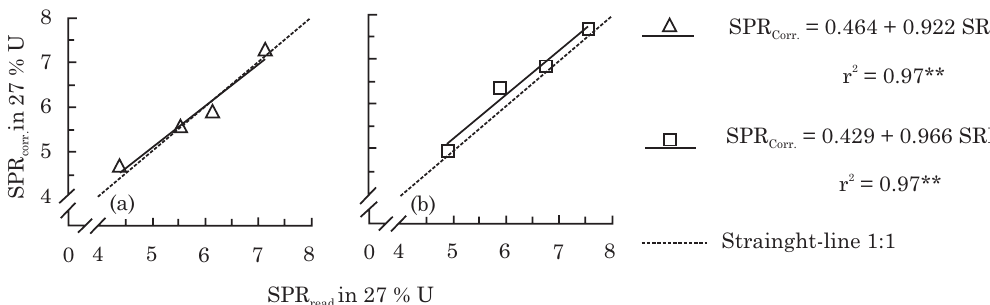
Figure 6. Relationship between the corrected value of soil penetration resistance (SPR corr ) and soil penetration resistance observed at the gravimetric soil water content (U) of 27 % (SPR read ), for the soil layers 5.5-10.5 cm (a), and 13.5-18.5 cm (b), of a Rhodic Eutrudox. Original data obtained by Torres & Saraiva (1999). **Statistically significant equations (F test,